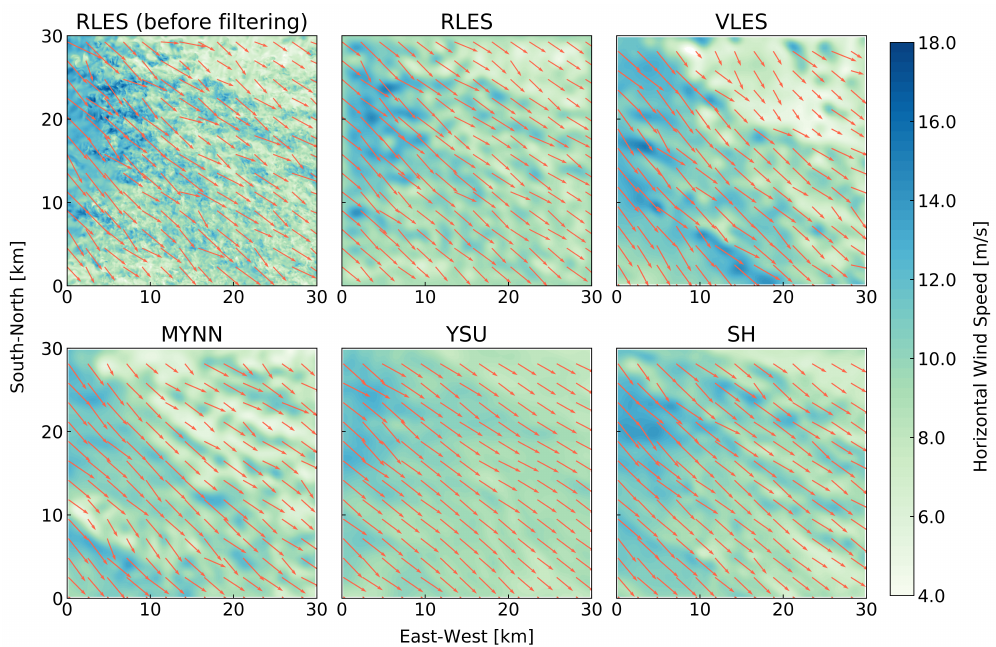
Figure 12. Contours of horizontal wind speed and wind direction vectors at z / z i = 0.5 for all simulation strategies on 28 March, 20:10 UTC (14:10 LT). This is the last time considered in the analysis of 28 March, as determined by the − z i / L convective regime categorization. For completeness, RLES is shown before and after spatial filtering.